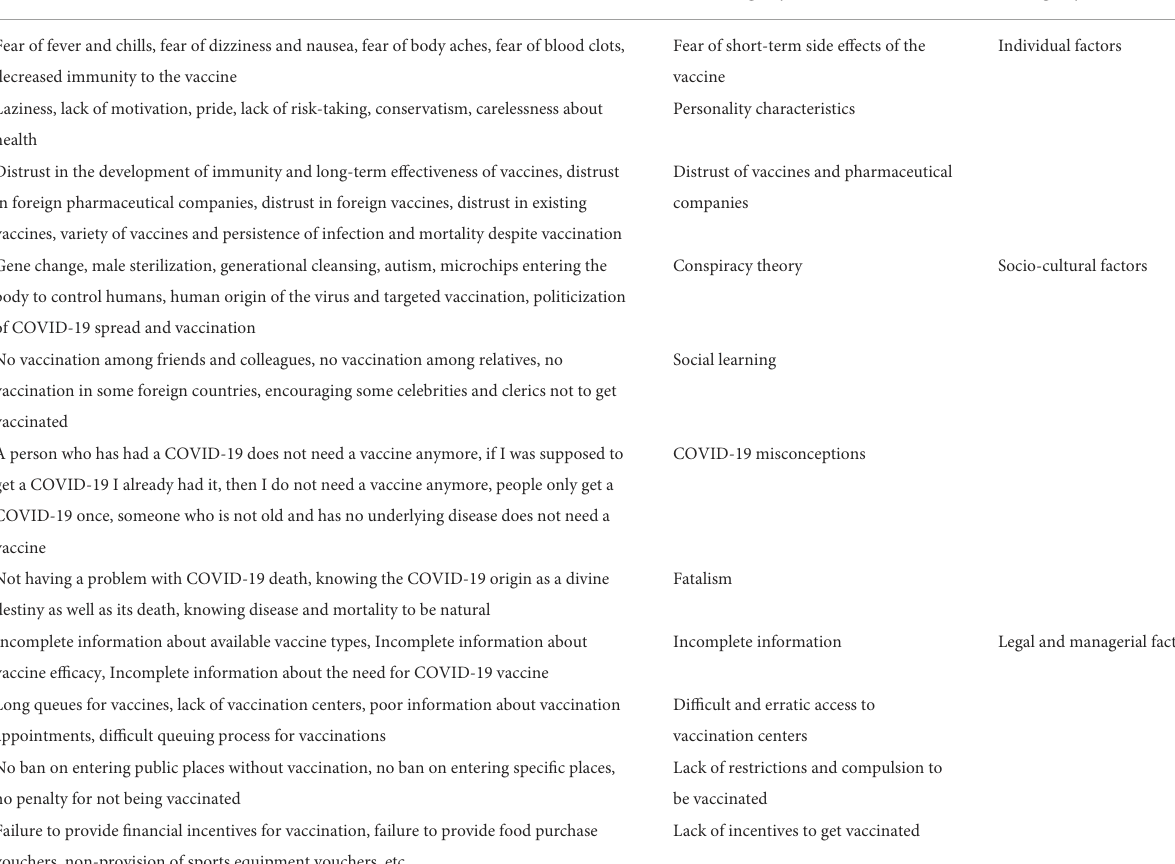
TABLE 3 Categories, subcategories, and codes obtained from